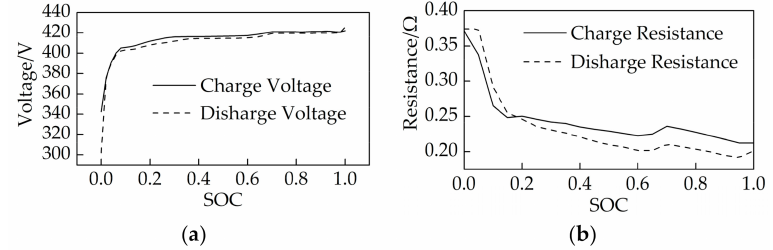
Figure 5. Battery model: ( a ) battery open circuit voltage; ( b ) battery internal